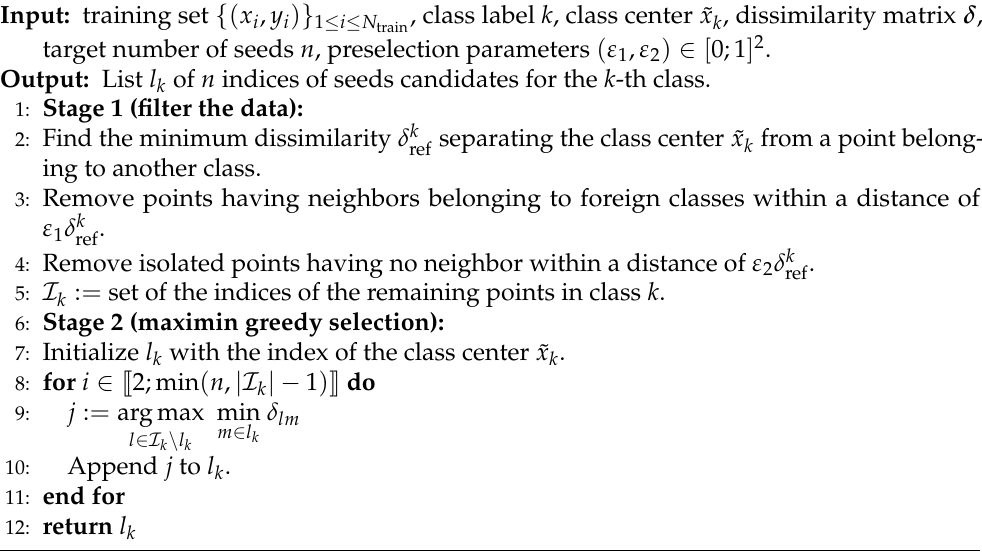
Algorithm 2 Seeds selection for data augmentation. Note: all the dissimilarities have already been computed in the data labeling